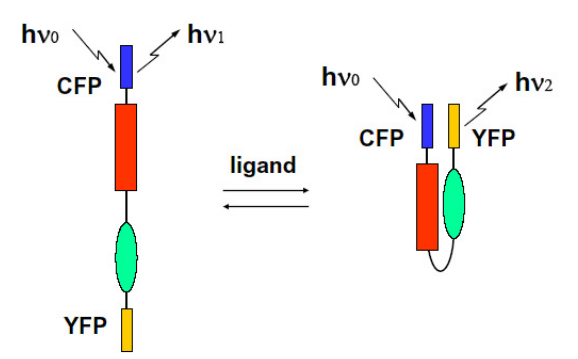
Figure 10. FRET phenomenon occurring